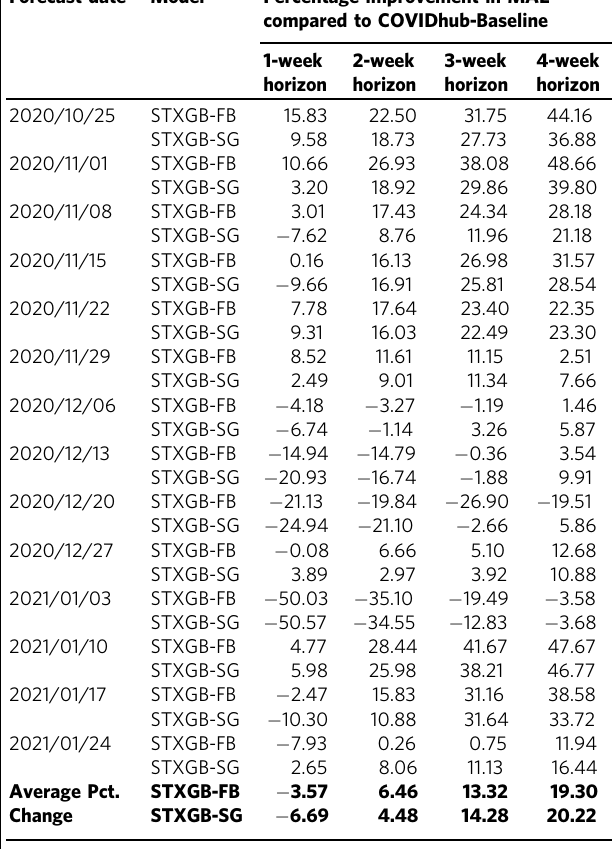
The average values for each model and across each horizon are